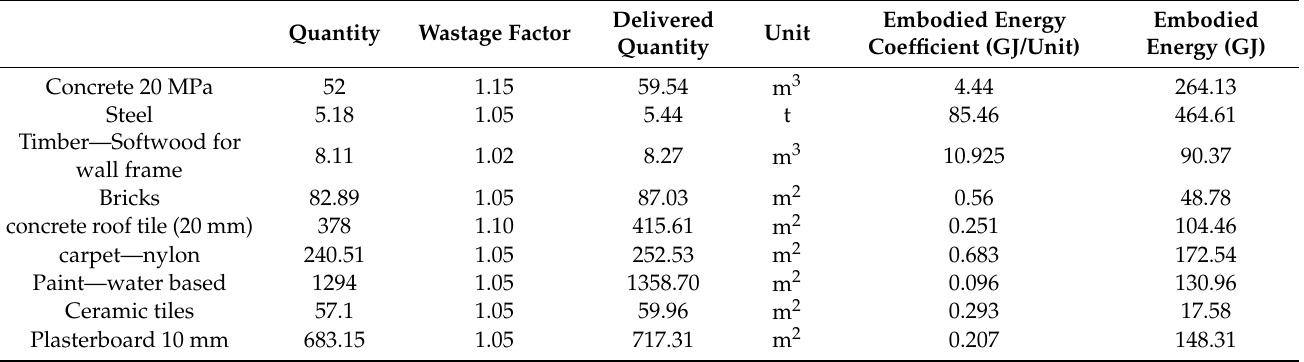
Table 3. Calculation of process-based hybrid-embodied energy for the selected materials of case study